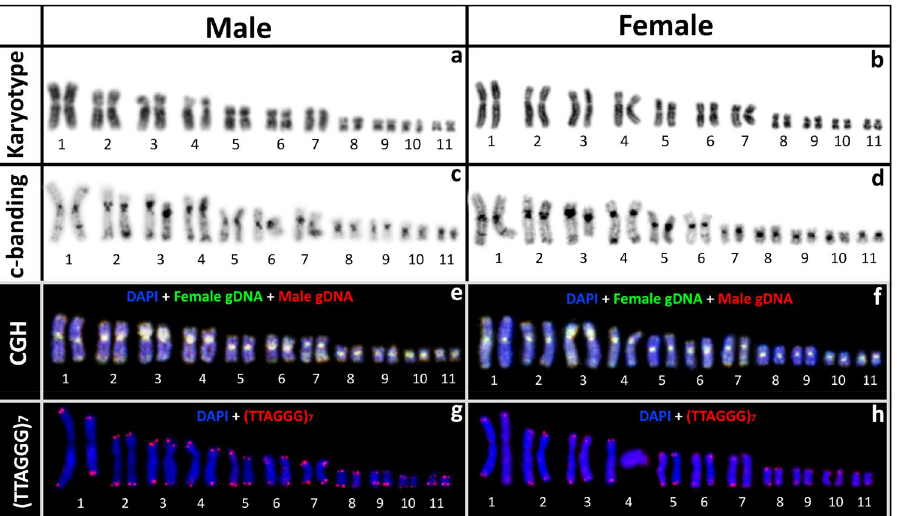
Figure 4. Cytogenetic screening of putative X and Y chromosomes in Platyplectrum ornatum . ( a ) DAPI stained karyotype of male. ( b ) DAPI stained karyotype of female. ( c ) DAPI stained c-banding karyotype of male. ( d ) DAPI stained c-banding karyotype of female. ( e ) Comparative Genome Hybridisation (CGH) in male. ( f ) Comparative Genome Hybridisation (CGH) in female. ( g ) Fluorescence in situ Hybridisation (FISH) with telomere specific probes in male. ( h ) Fluorescence in situ Hybridisation (FISH) with telomere specific probes in